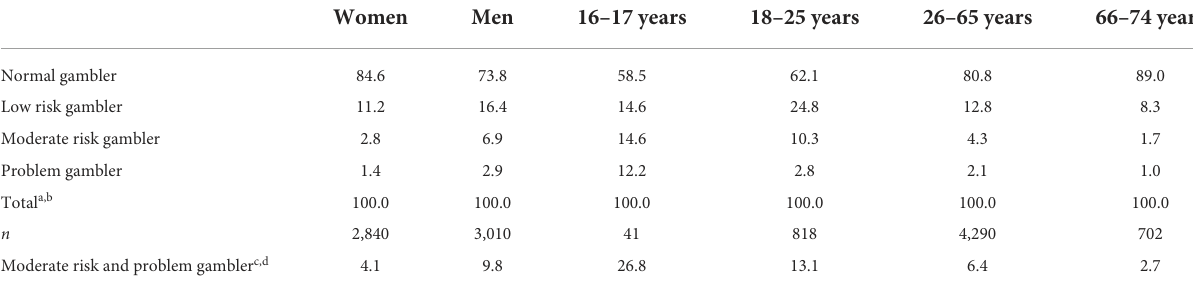
TABLE 4 Percentage of gamblers in each Canadian Problem Gambling Index category, by gender and